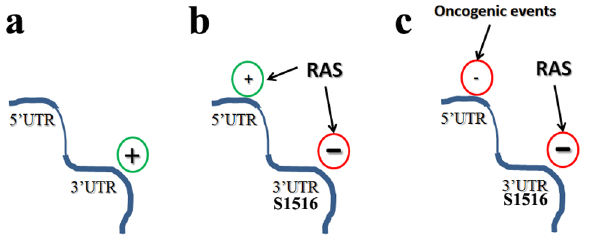
Figure 7. Model of the post-transcriptional regulation of Cx43 expression in normal and transformed cells. a) In normal cells, the 3 9 UTR exerts a positive regulation on Cx43 expression. b) Ras-mediated transformation exerts a blockade on a regulatory element